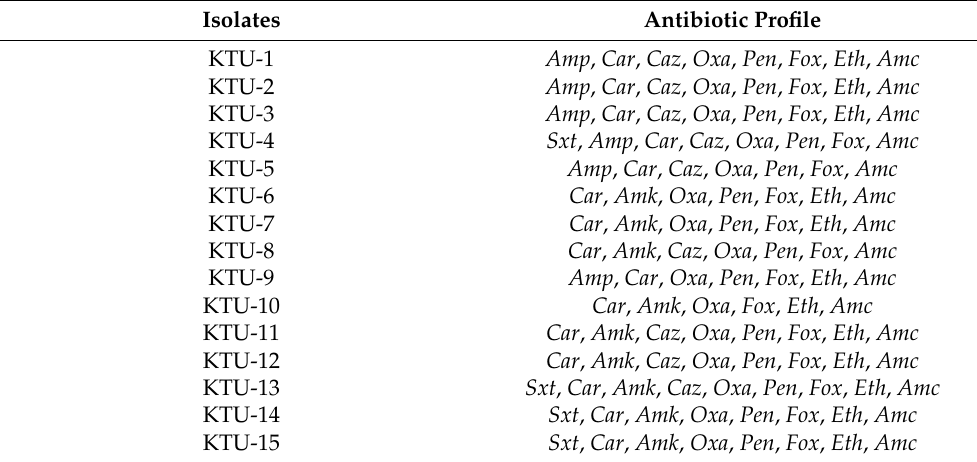
Table 3. Antibiotic resistance profile of Klebsiella pneumoniae isolates.